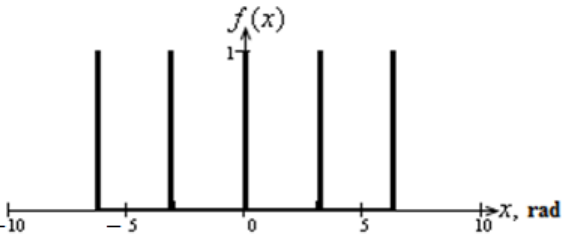
Figure 10. Graph of the approximating function describing the pulse processes regulating the pa-